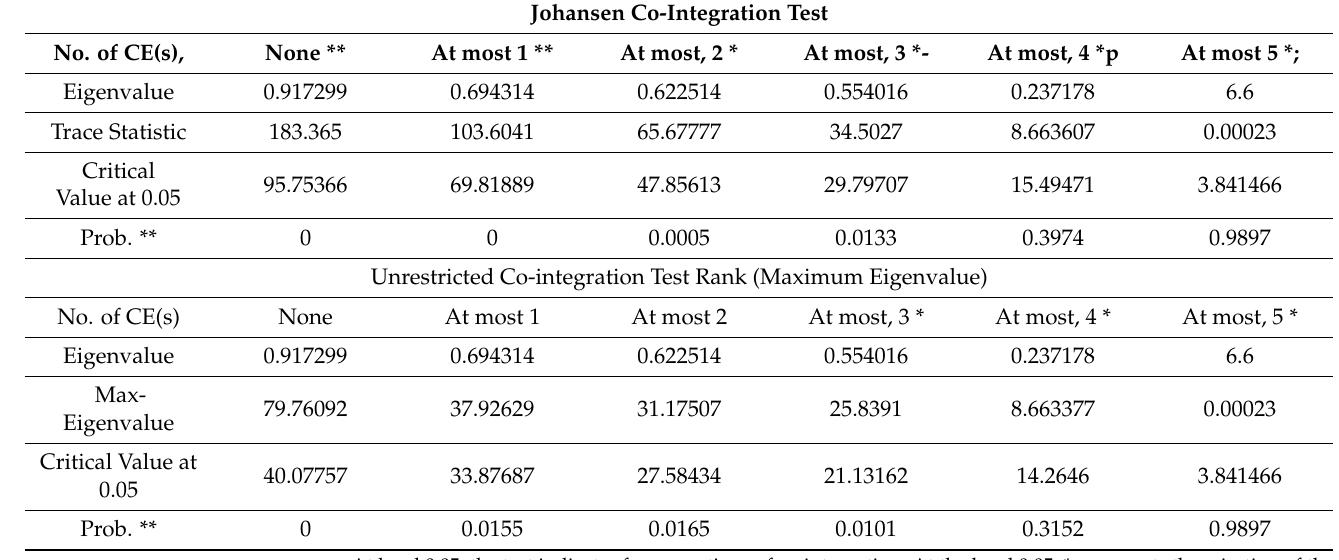
Table 1. Test of Johansen co-integration.